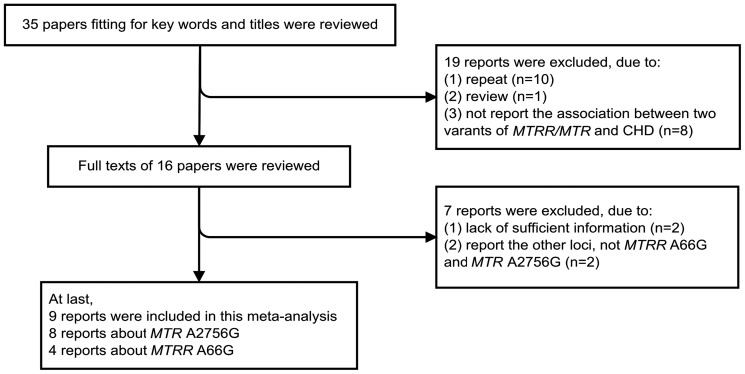
The flow chart for selection of primary studies and specific reasons for exclusion in this meta-analysis.